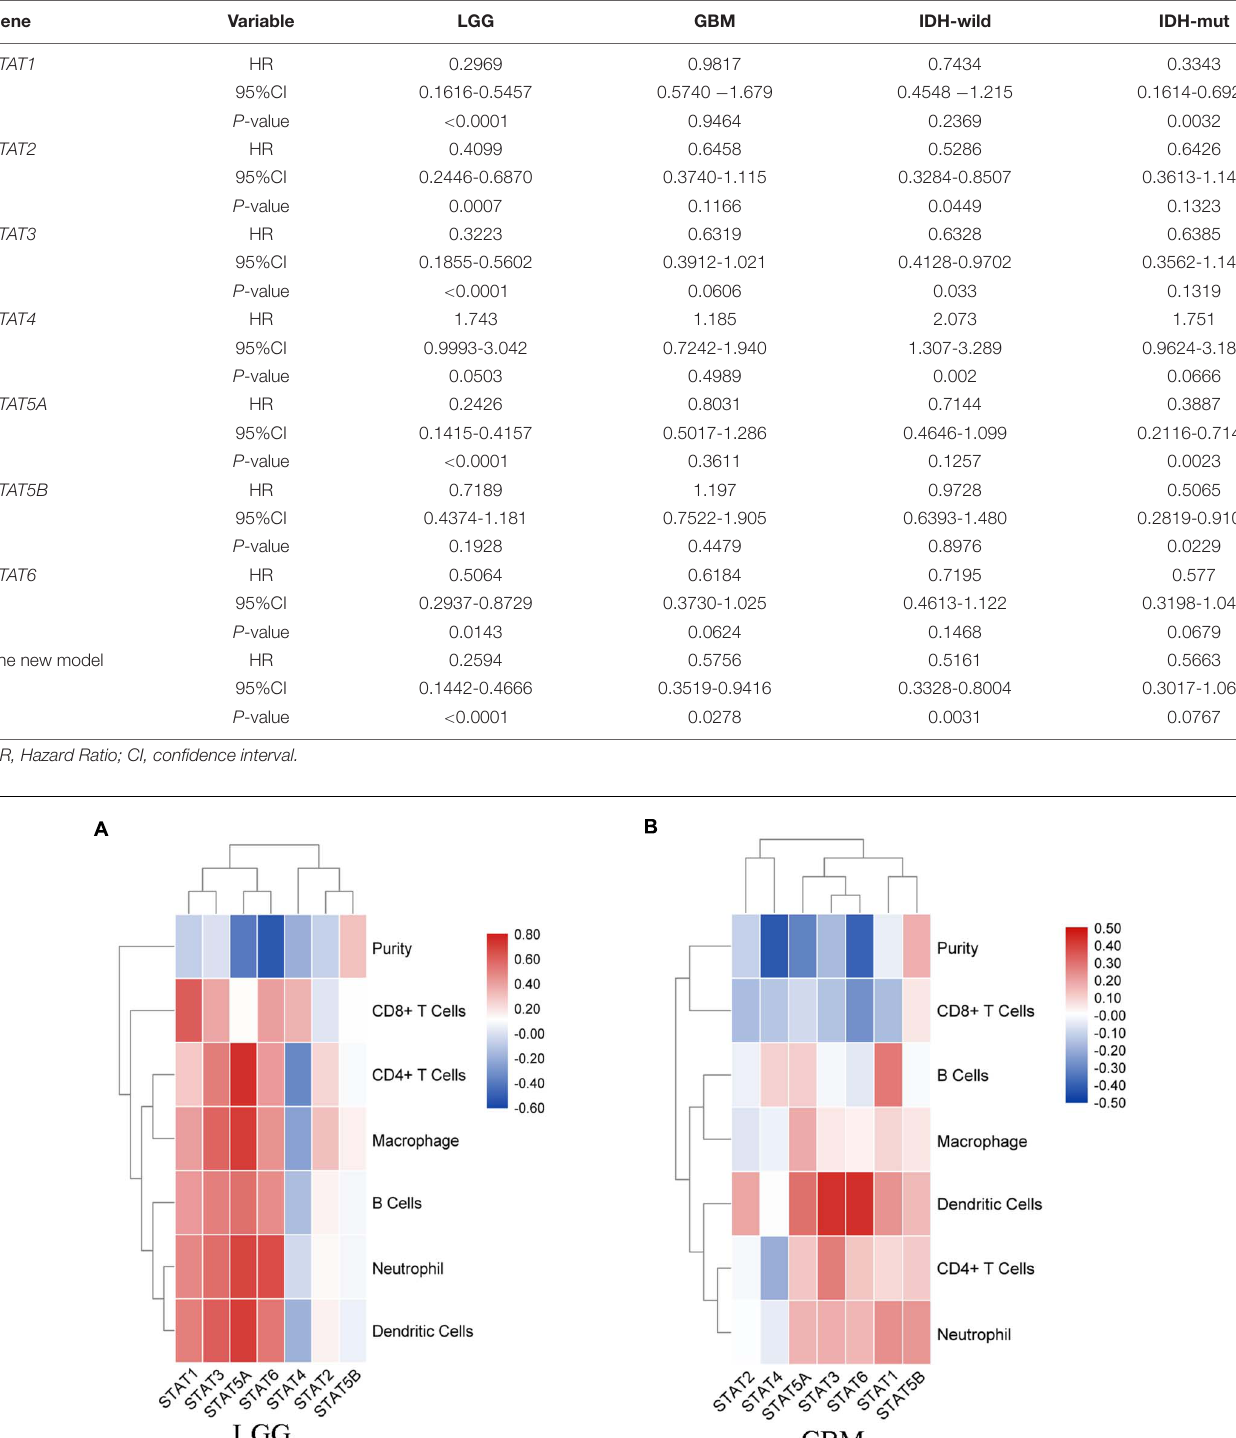
TABLE 3 | Subgroup analysis of the prognostic value of STATs in CGGA.